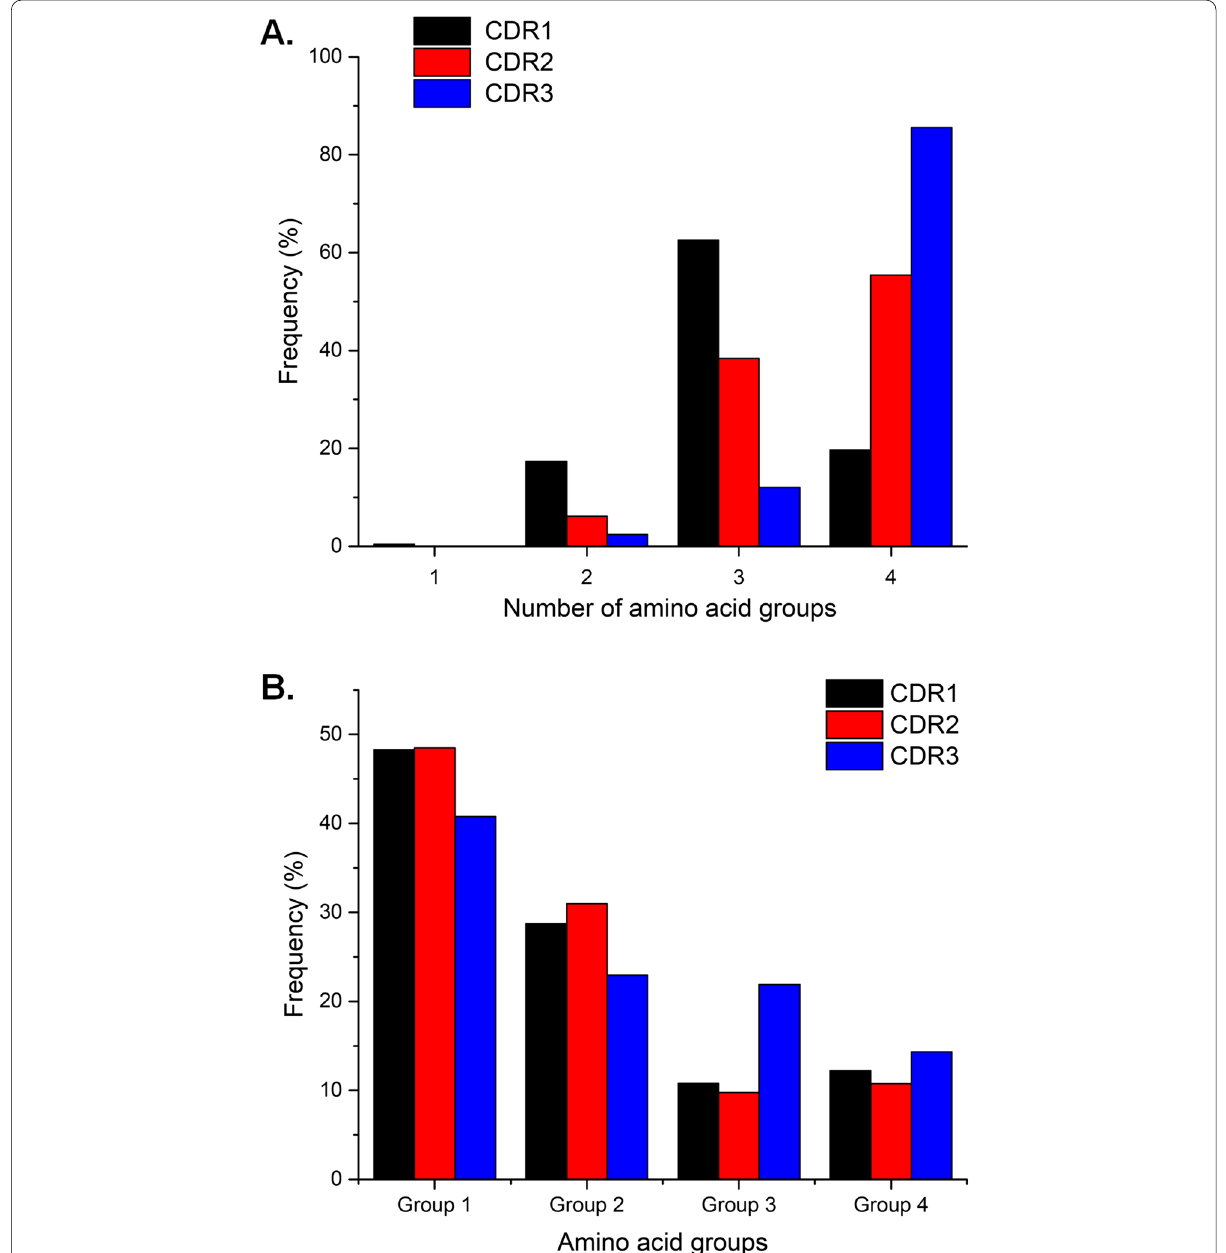
Fig. 3 Frequency of the total number of AA groups ( A ) and frequency of each AA group in CDRs of Nbs ( B